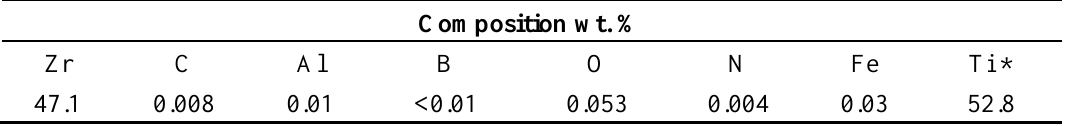
Figure 1. Photograph of the VAR-fabricated TiZr ingot, which was 240 mm in diameter, 384 mm in length, and 85.4 kg in weight. Table 1. Chemical composition of the vacuum arc remelting (VAR)-fabricated TiZr ingot. Composition wt.